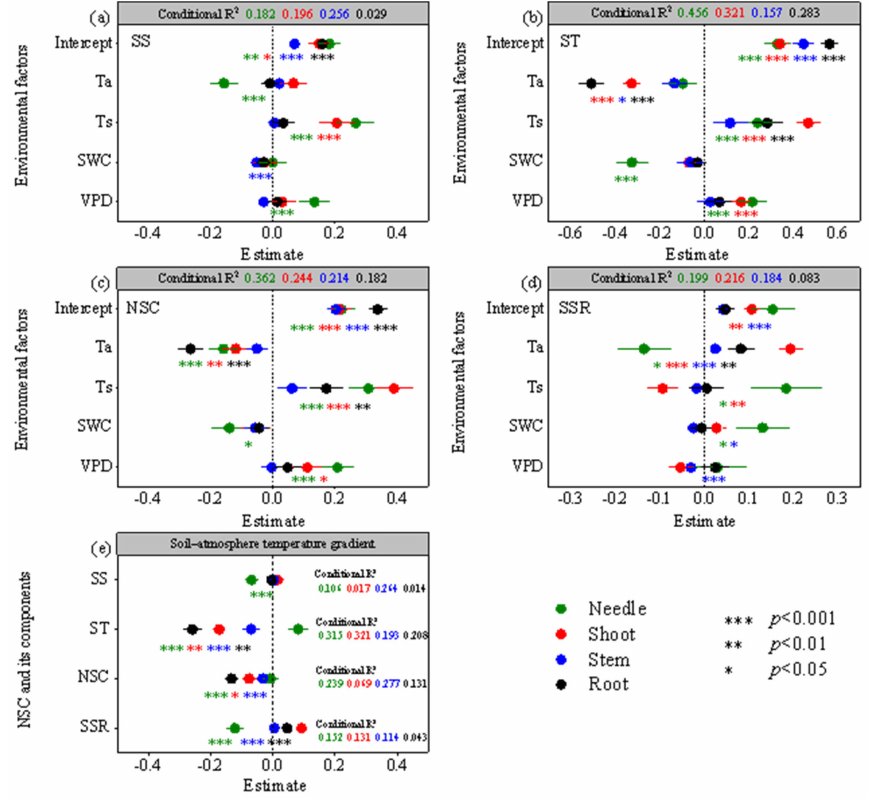
Figure 3. Estimated effects of Ta (air temperature), Ts (soil temperature), SWC (soil water content), and VPD (vapor pressure deficit) on the ( a ) soluble sugars (SS), ( b ) starch (ST), ( c ) NSC, and ( d ) soluble sugar–starch ratios (SSR) in the needles, shoots, stems, and roots. Moreover, the estimated effects of ( e ) soil–atmosphere temperature gradient ( ∆ T = Ta − Ts) on the soluble sugars (SS), starch (ST), NSC, and soluble sugar–starch ratios (SSR) in the needles, shoots, stems, and roots. Conditional R 2 : induced by both fixed effects and random effects R 2 .